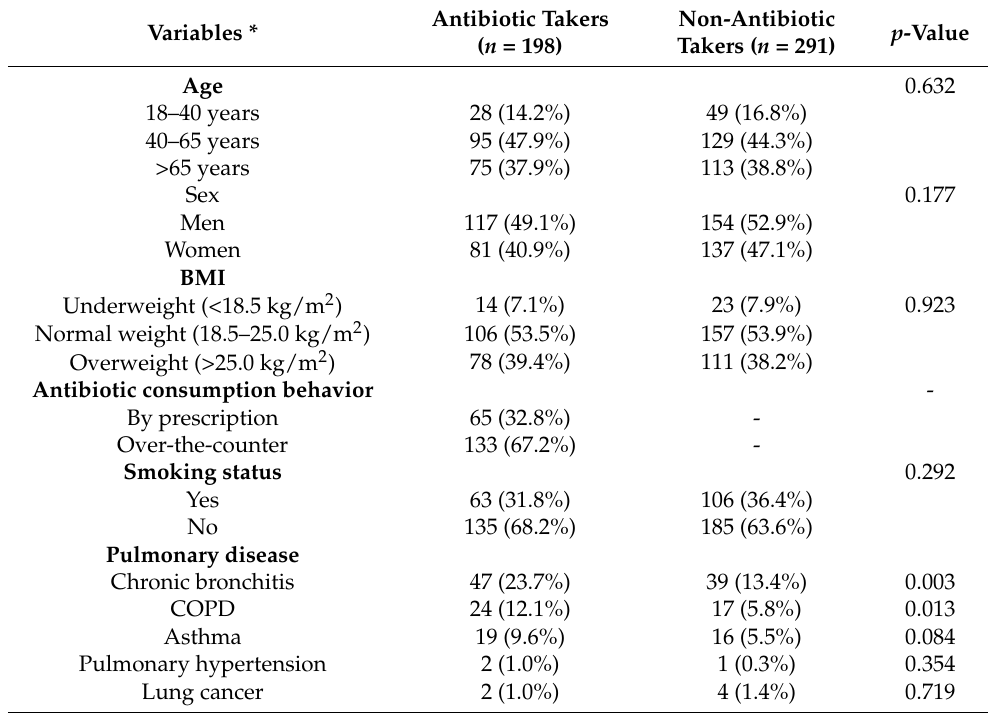
Table 1. General characteristics of COVID-19 patients with secondary bacterial infections stratified by antibiotic-use